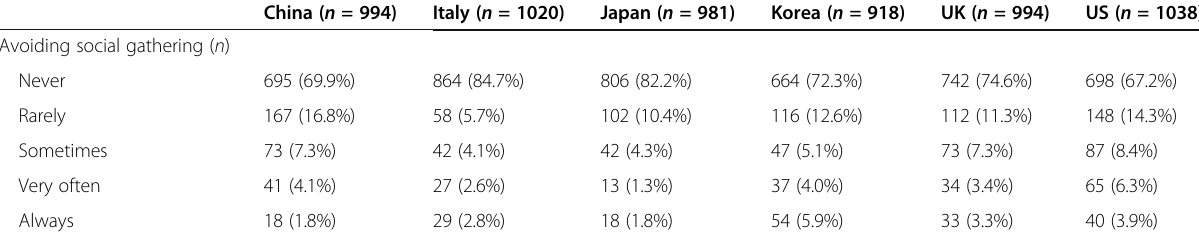
Table 2 Public perception and personal characteristics of participants by six countries